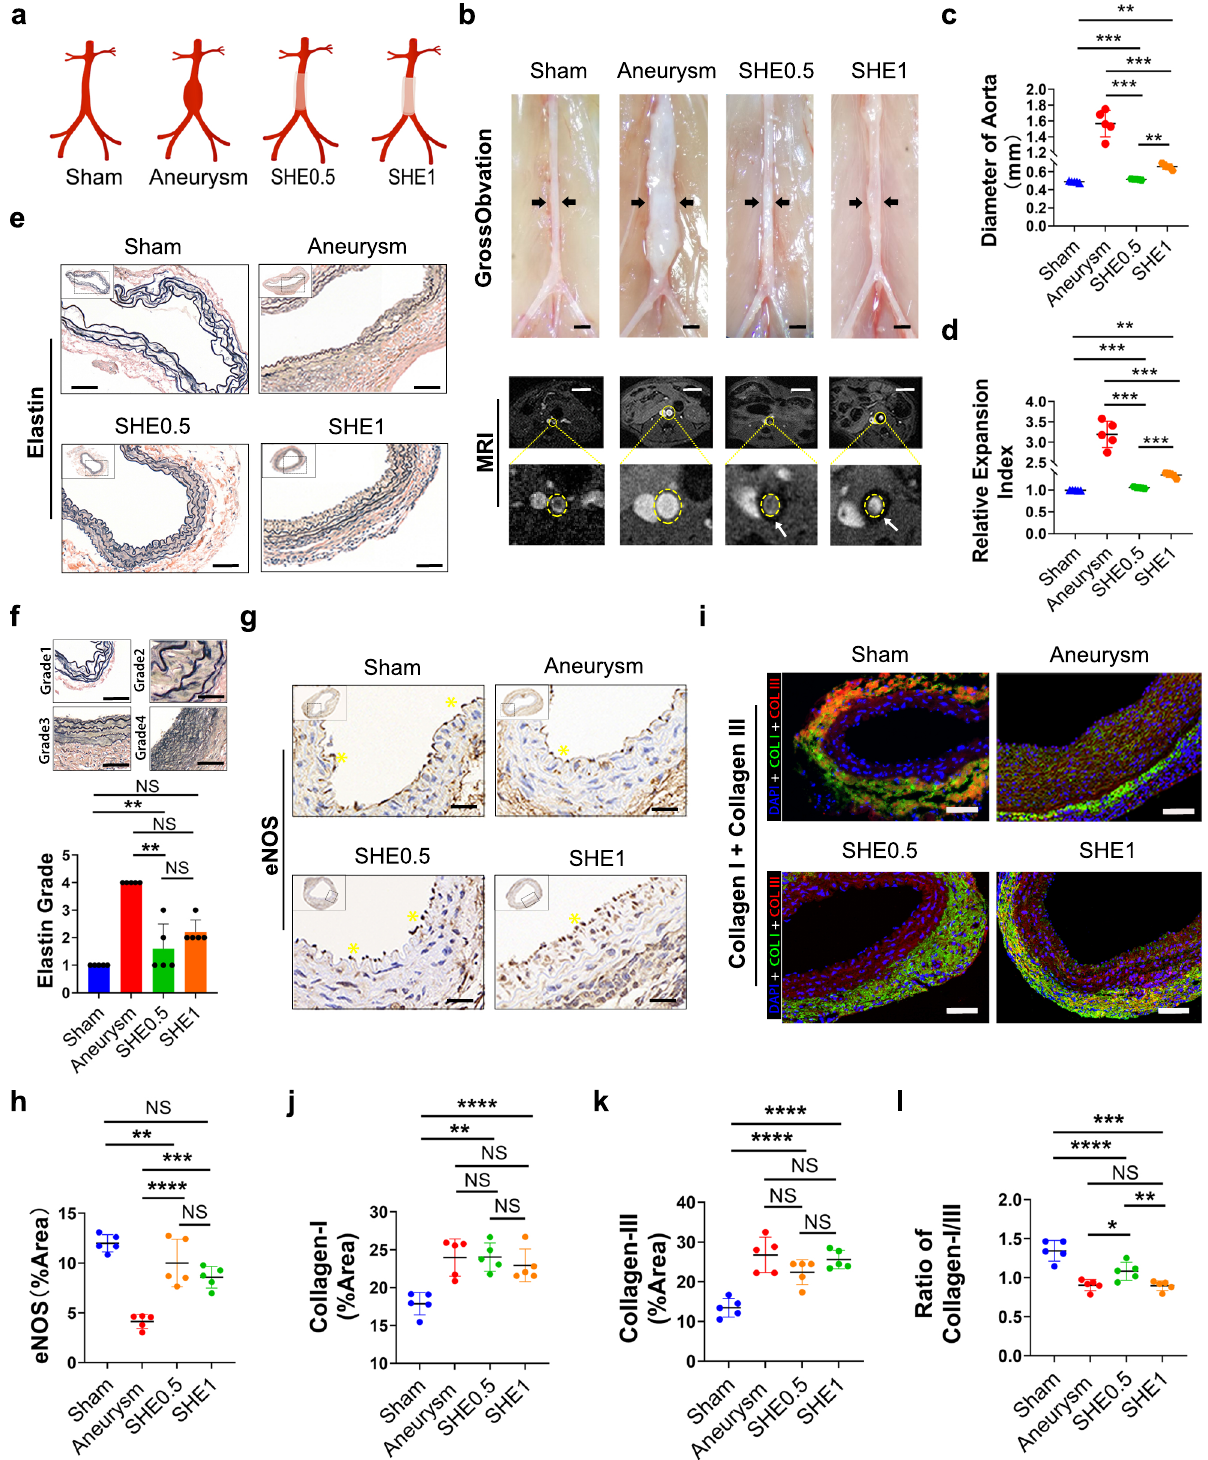
nerve fi bres in the SHE0.2 group was signi fi cantly higher than that in the suture, fi brin and PCL-conduit groups, while there was no difference compared to that in the sham group (Fig. 4m, 4n, and Supplementary Fig. 26B, C). Histomorphometry revealed that the myelin thickness and number of axons counted under TEM were still higher in the SHE0.2 group than in the suture, fi brin-glue and PCL-conduit groups but lower in the SHE0.2 group than in the sham group (Supplementary Fig. 29).